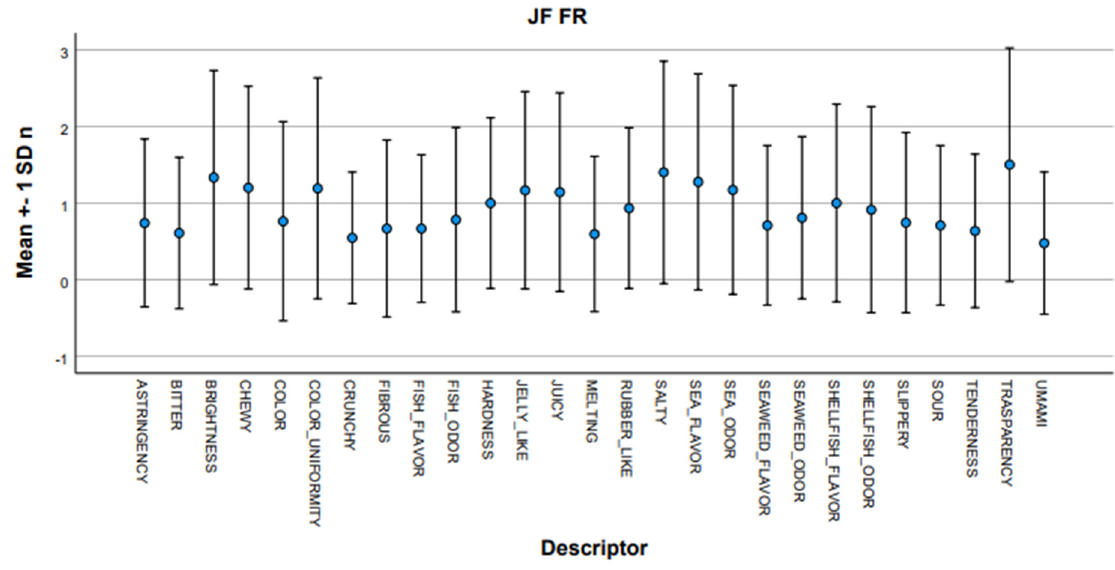
Figure 3. Error bar of the intensity mean score for descriptors selected for sample JF-FR. Bars represent standard deviation.